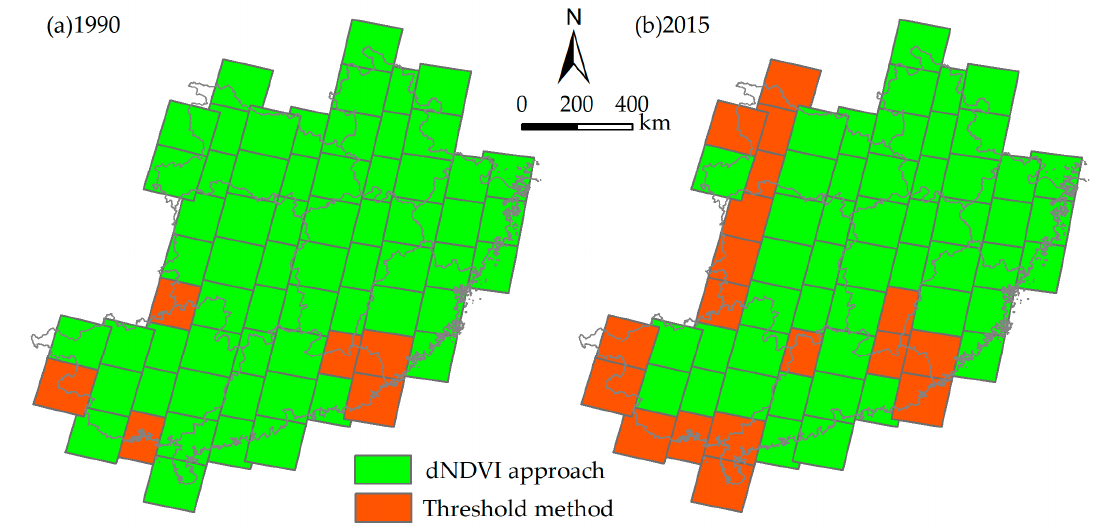
Figure 5. The distribution of scenes to which the single image threshold method or the difference of Normalized Difference Vegetation Index (dNDVI) approach was applied: ( a ) 1990; ( b ) 2015.